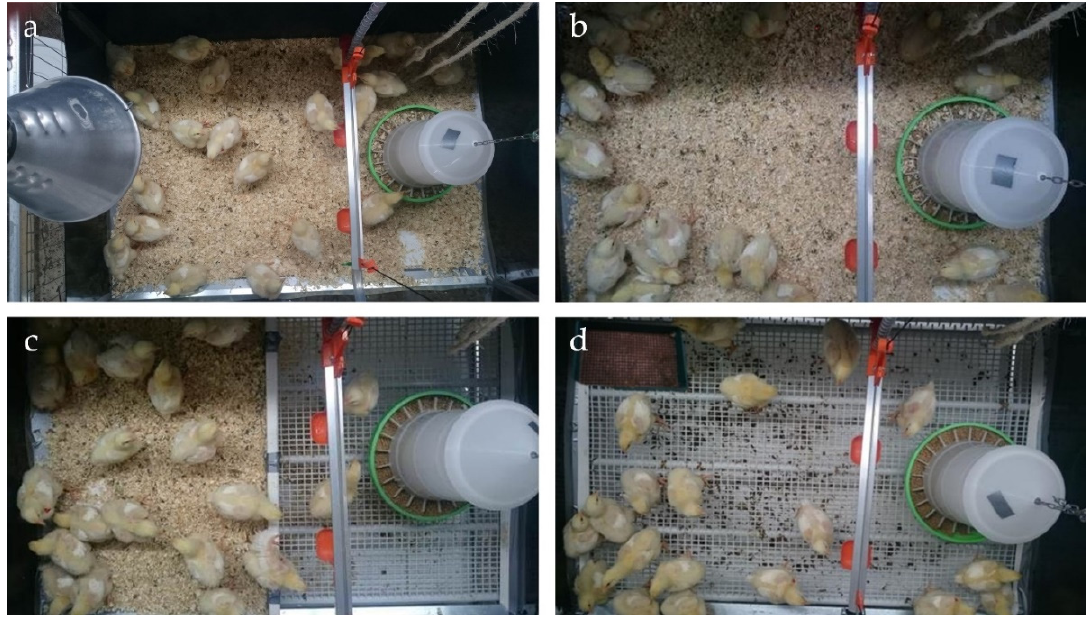
Figure 1. Characteristics of flooring designs: ( a ) entire floor pen covered with litter; ( b ) floor pen covered with litter and floor heating; ( c ) partially slatted flooring; ( d ) fully slatted flooring with sand bath (photo: © Kriewitz/TiHo).